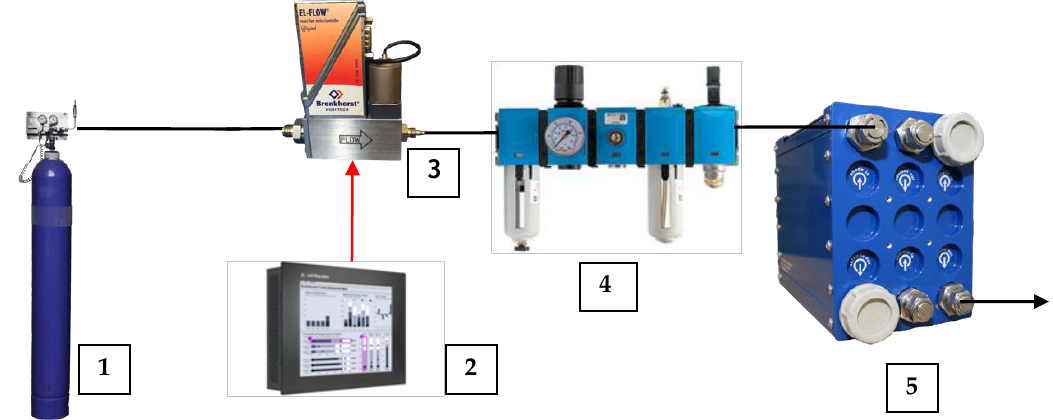
Figure 4. Structure of oxygen subsystem in configuration without recirculation; 1, oxygen storage unit; 2, controller; 3, oxygen flow regulator; 4, oxygen preparation block; 5, PEM fuel cell stack.